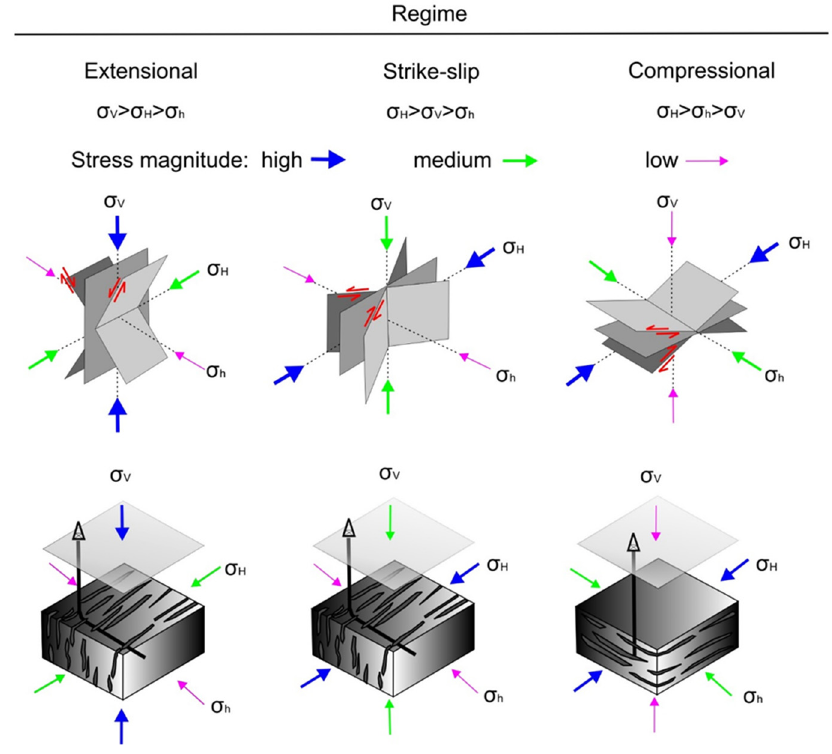
Figure 4. Tectonic regimes and stresses activity. Based on [20].